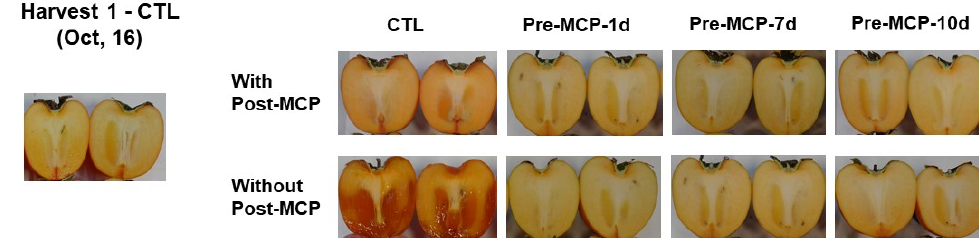
Figure 2. Captured images of ‘Rojo Brillante’ persimmon at harvest (on 16 October) and after the commercialization period (3d at 3 °C plus 6d at 20 °C). Fruit was preharvest treated with 1-MCP applied on days 1 (pre-MCP-1d), 7 (pre-MCP-7d) or 10 (pre-MCP-10d) after ethephon treatment and postharvest treated or not with 1-MCP (post-MCP). CTL is the fruit without preharvest 1-MCP treat- ment.